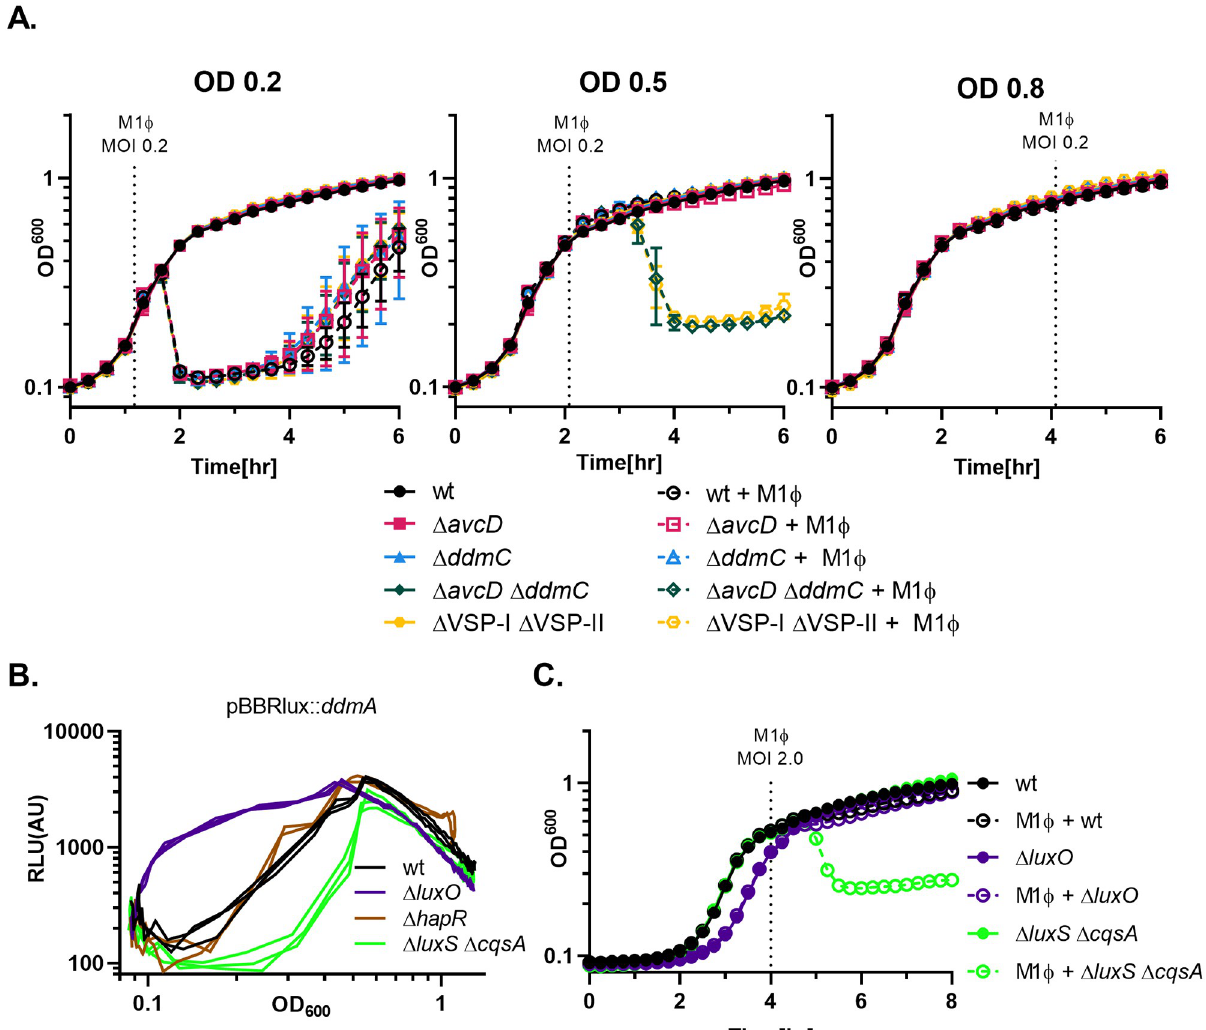
Fig 6. Defense by DdmC is controlled by quorum sensing. (A) Growth and lysis curves of V . cholerae infected by M1 F at different cell densities. M1 F was added at an MOI 0.2 at the time indicated with a dotted line that corresponds closely with the OD 600 shown at the top of each graph. Strains used for all three graphs are indicated on the far right of the figure. (B) Quorum sensing mutant strains of V . cholerae carrying the reporter plasmid pBBRlux with the lux operon under the control of the region upstream of ddmA were grown at 37˚C with shaking. Optical density (OD 600 ) and bioluminescence were measured at regular intervals. Relative luminescence (RLU) was calculated by dividing the luminescence by optical density and was then plotted relative to the OD 600 to show the normalized bioluminescence throughout growth. (C) Grow and lysis curves of C6706 (WT) and various quorum sensing mutants upon M1 F infection. M1 F was added to the indicated strains at the dotted line at an MOI of